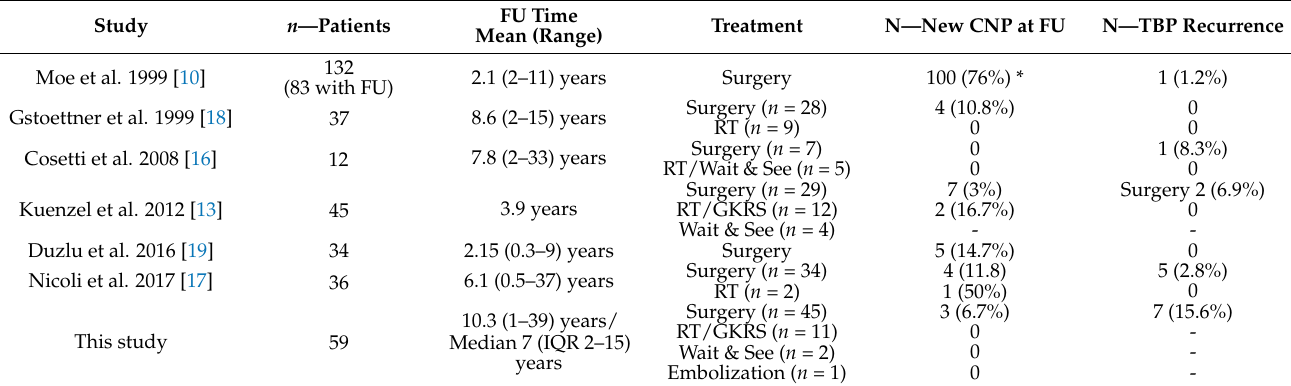
Table 3. Comparison of treatment protocols and results in Fisch A to D TBPs among different centers.